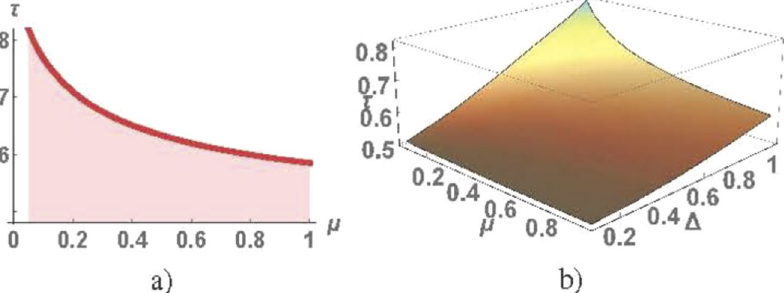
Figure 3. Low energy spectra with edge modes of the one-dimensional strip along the x -direction as a function of the momentum directed along the edge. The energies are calculated at the Kitaev point Δ = 1 for µ = 1 Q = π left), π = Q 1 1 right) and for different τ . 4